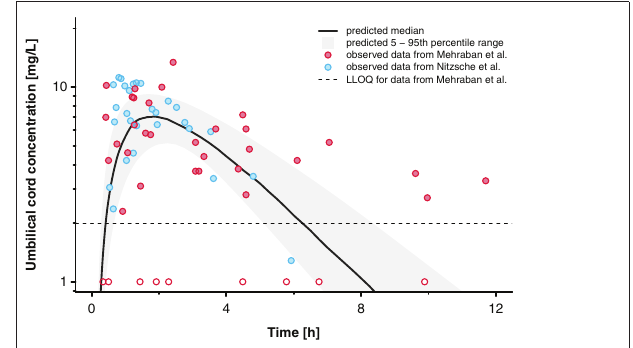
FIGURE 6 | Concentration time profiles for acetaminophen in the umbilical cord. Blue and red circles indicate observed clinical data reported by Nitsche et al. ( 17) and Mehraban et al. (18). Data from Mehraban et al. (18) below the lower limit of quantification (LLOQ), shown as dashed line, are included as LLOQ/2 and empty circles in the figure. The black line indicates the predicted median and the shaded area the predicted 5–95th percentile range.